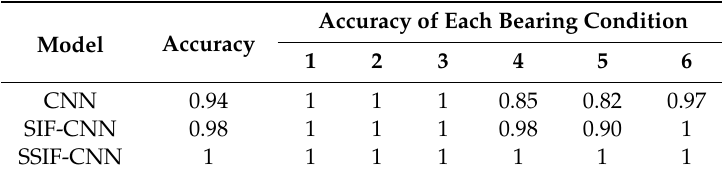
Table 13. The classification accuracy of the testing samples.